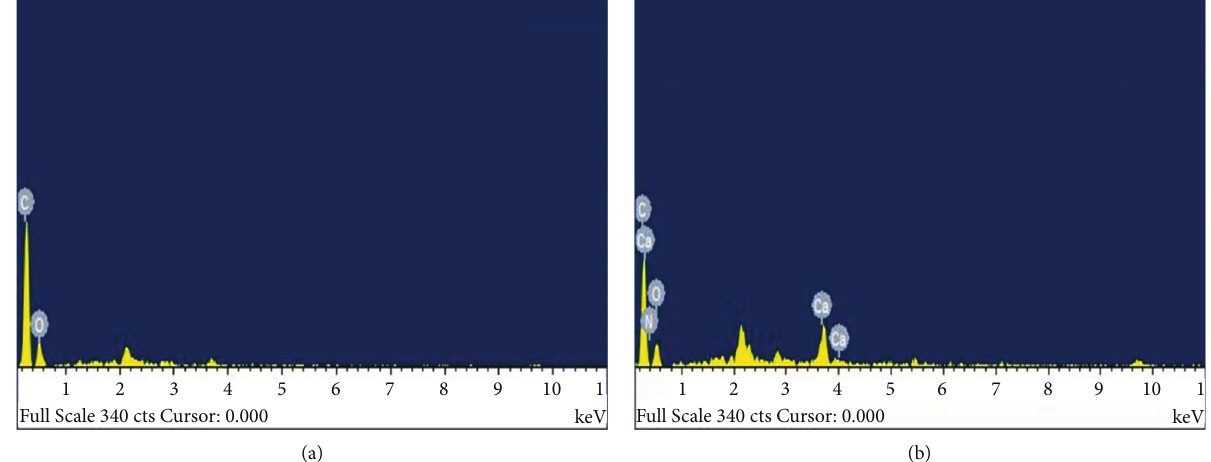
Figure 2: EDAX analysis of Neolamarckia cadamba : (a) unloaded; (b) loaded with methylene